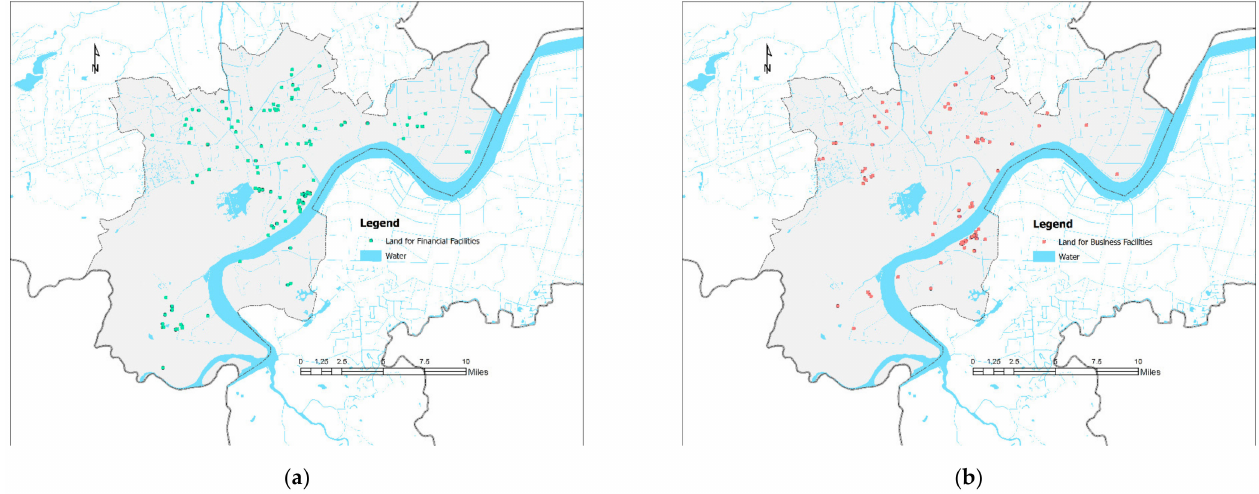
Figure 5. ( a ) Plot of land for financial facilities (Commercial land category 1) in Hangzhou’s main urban area; ( b ) Plot of land for business facilities (Commercial land category 2) in Hangzhou’s main urban